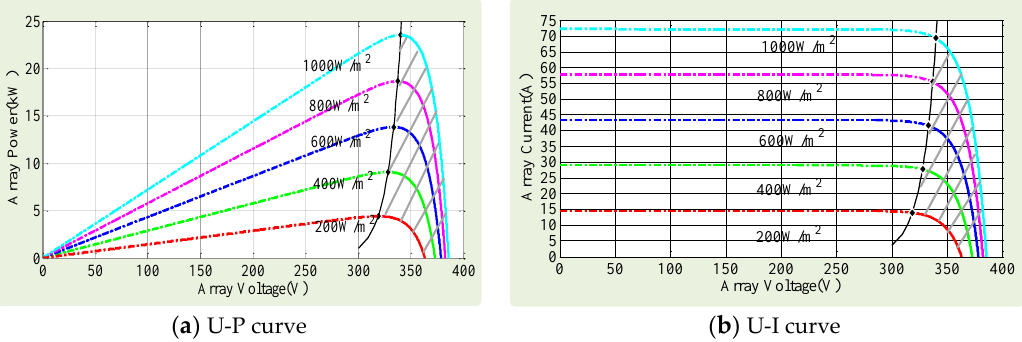
Figure 5. Stable PV module operating regions for constant voltage control, at different irradiances.